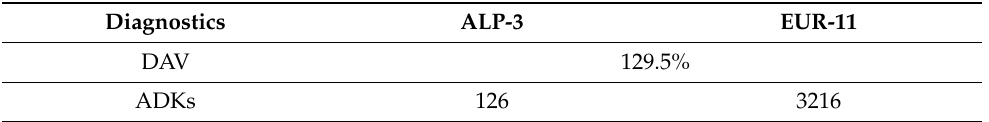
Table 6. DAV and ADKs referred to the hourly CDF and PDF of heavy precipitation in Figure 5. Diagnostics